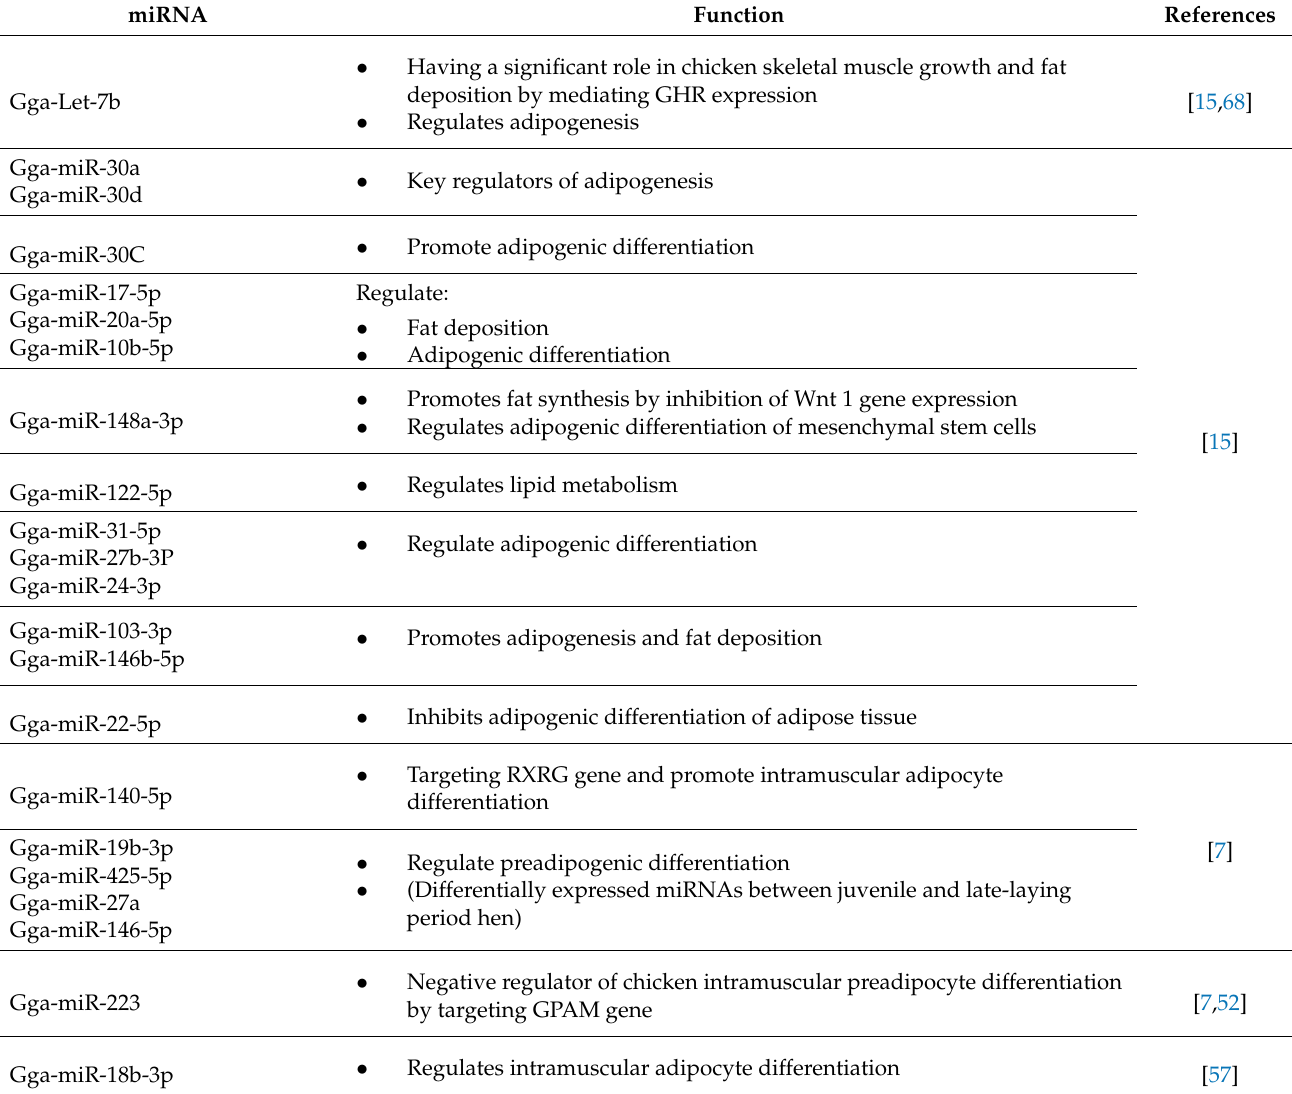
Table 3. Summary of the significantly expressed miRNAs associated with intramuscular adipogenesis in chicken. miRNA